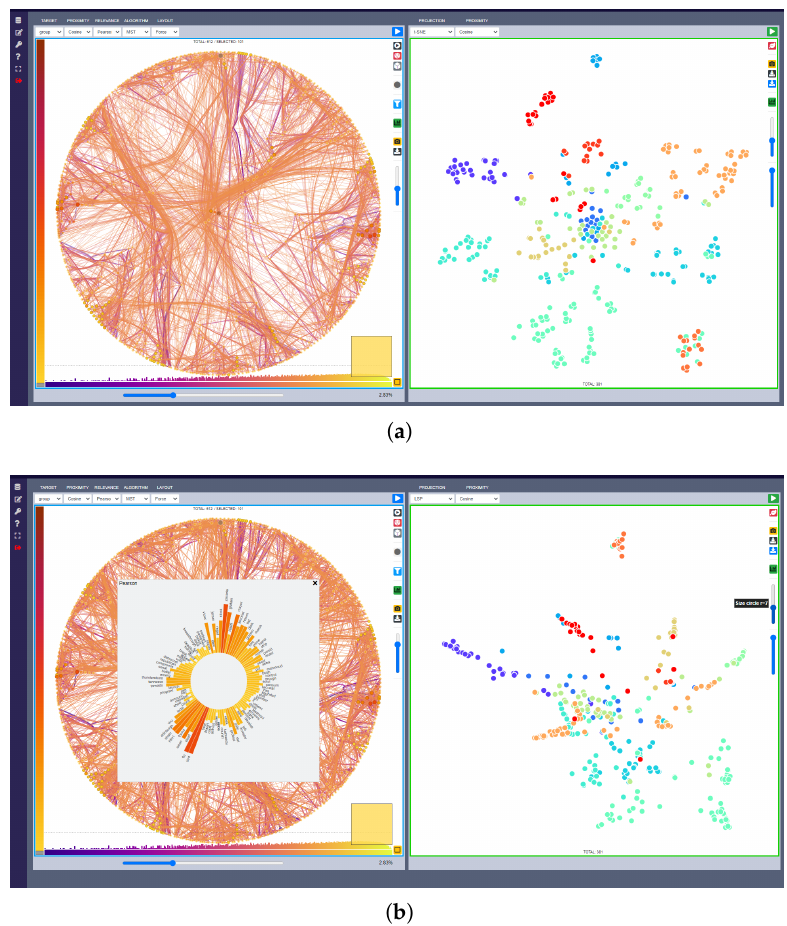
Figure 3. News data. ( a ) A graph from features (left) connecting the top 3% similarities between 612 features. A t-SNE projection (right) was generated with 101 features selected from the graph. ( b ) A circular histogram showing the features selected from the graph (left) and an LSP projection from the same set of features